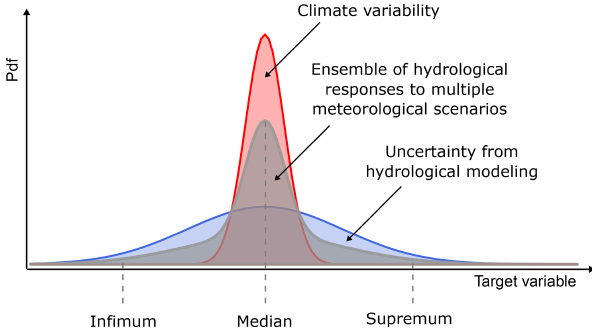
Figure 1. Framework overview. The infimum and supremum refer to the largest interval bounding the ensemble simulation from below and the smallest interval bounding it from